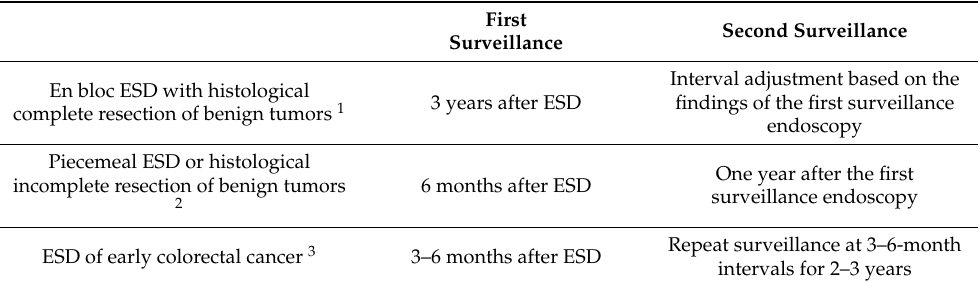
Table 5. Proposal of surveillance endoscopy strategies after colorectal ESD.